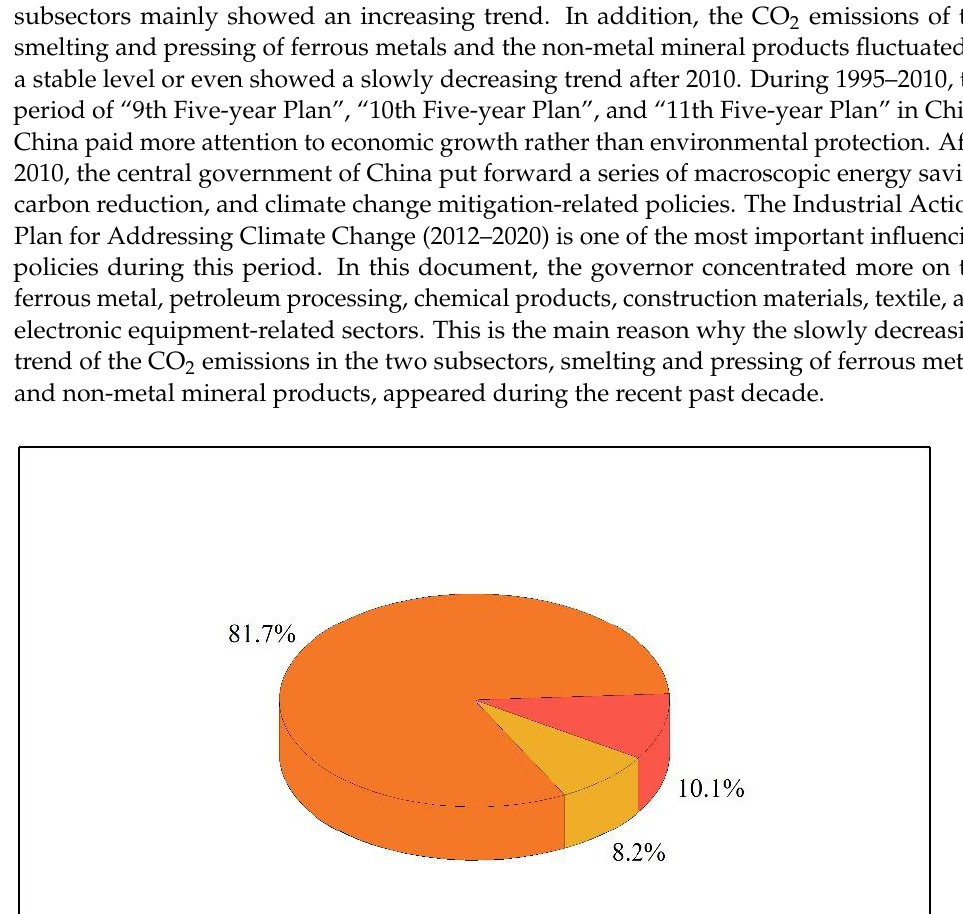
Figure 4. CO 2 emissions from industrial sub-sectors during 1995 – 2019.